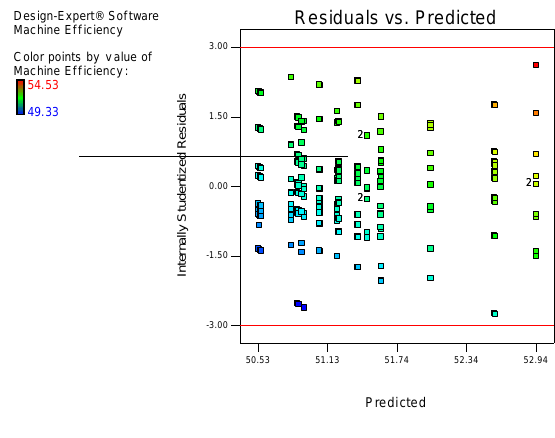
Figure 12. Residuals versus predicted values for machine efficiency